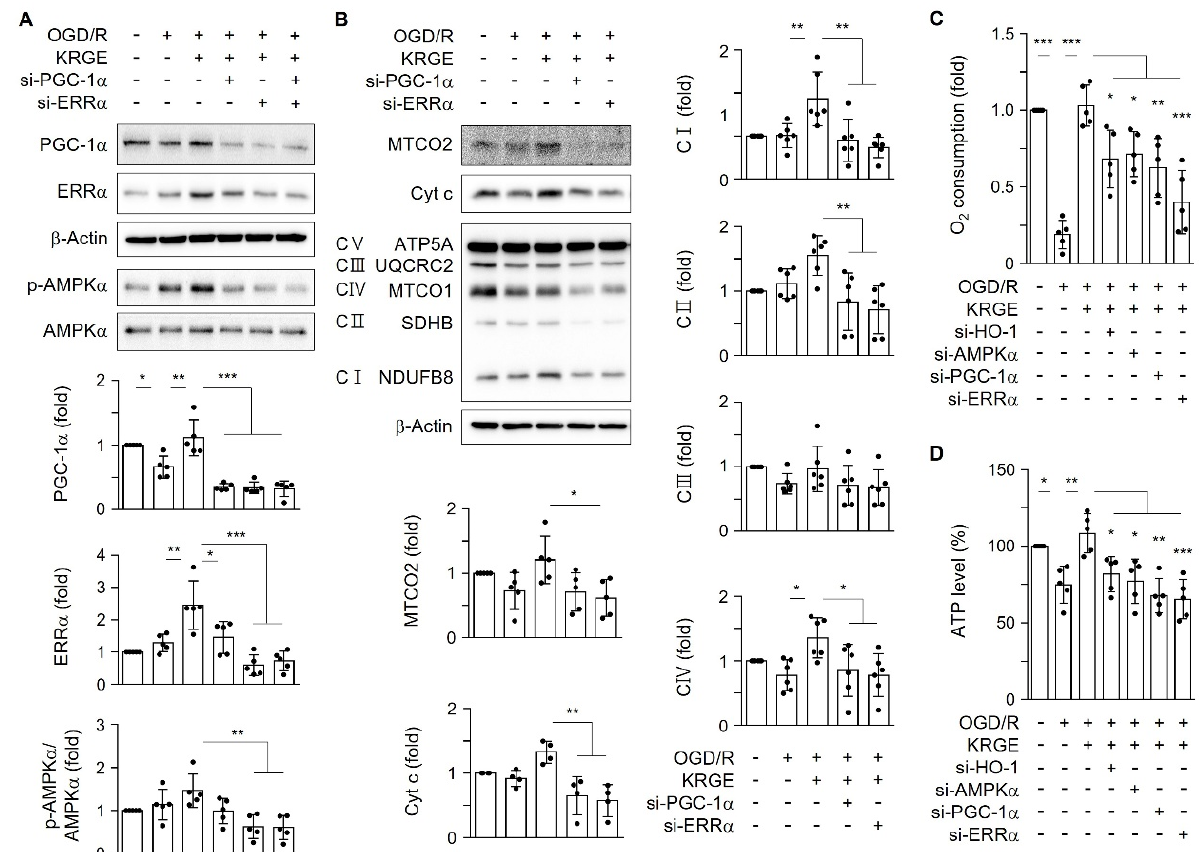
Figure 5. The KRGE-mediated PGC-1 α -ERR α axis regulated mitochondrial functional proteins. ( A , B ) Astrocytes were transfected with 50 nM siRNAs for PGC-1 α (si-PGC-1 α ) or/and ERR α (si-ERR α ). Subsequently, the cells were subjected to OGD/R followed by treatment with 250 µ g/mL KRGE. Indicated protein levels were detected by Western blotting. ( C ) Mitochondrial oxygen consumption was detected ( n = 5). ( D ) ATP levels are shown ( n = 5). * p < 0.05; ** p < 0.01; *** p < 0.001.